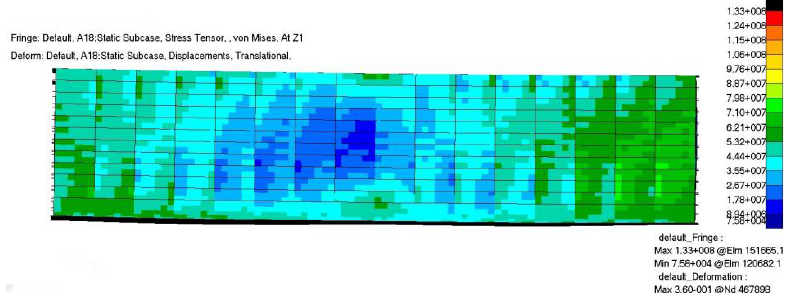
Figure 20. Stress cloud diagram of cabins 4 and 5 when just sitting on the sand.